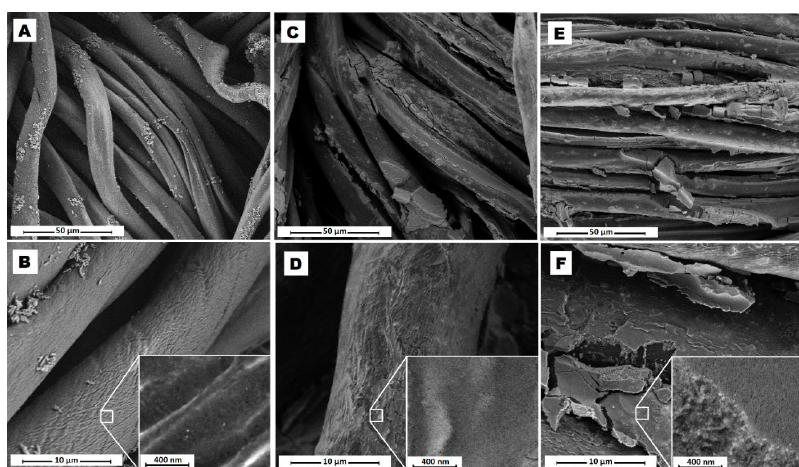
Figure 3. SEM-FEG images of untreated cotton textile ( A , B ), blue Ir@SiO 2 -coated textiles ( C , D ), red Ir@SiO 2 -coated textiles ( E , F ) at different magnification.